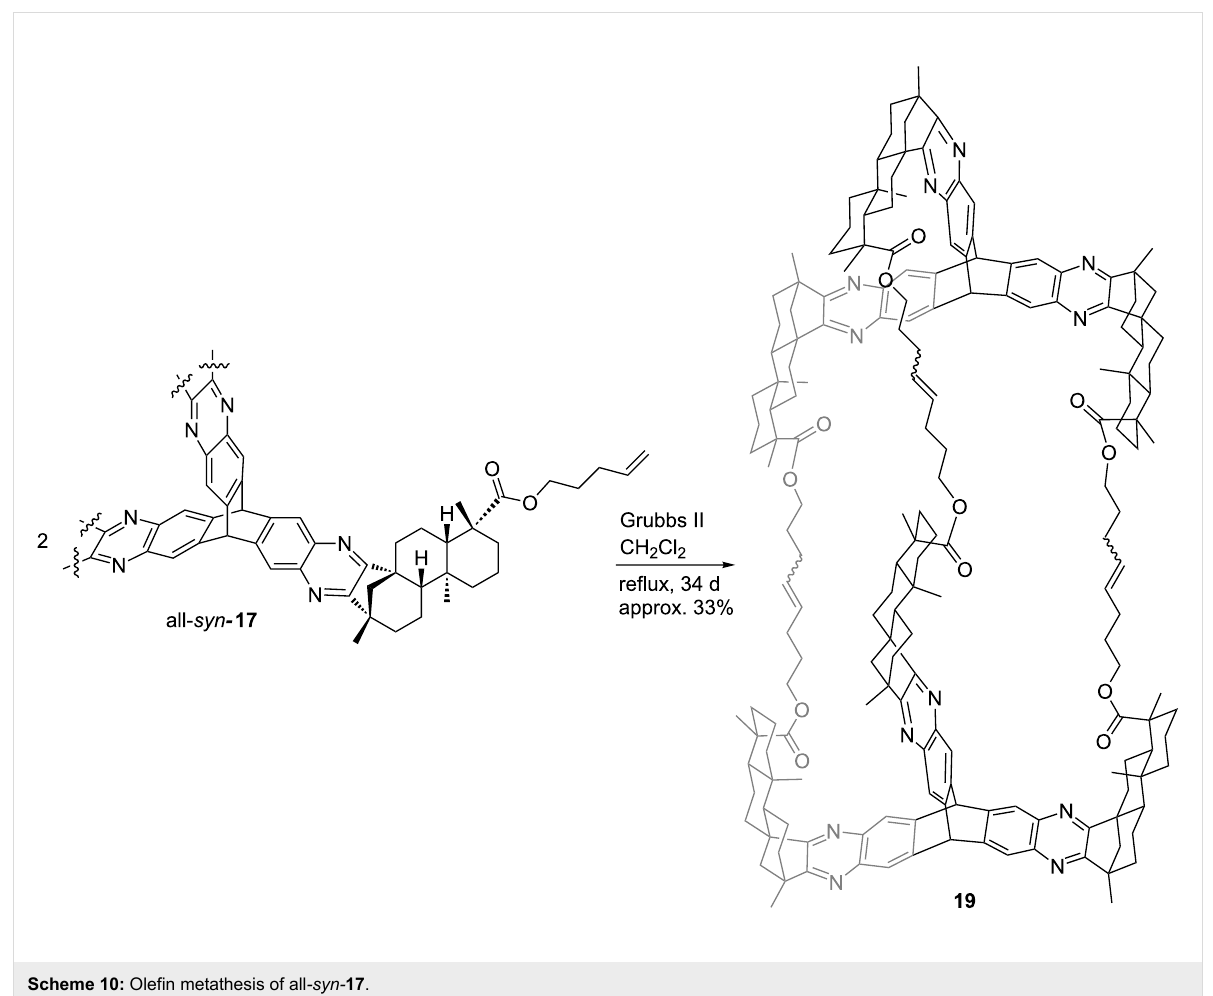
Scheme 10: Olefin metathesis of all -syn- 17